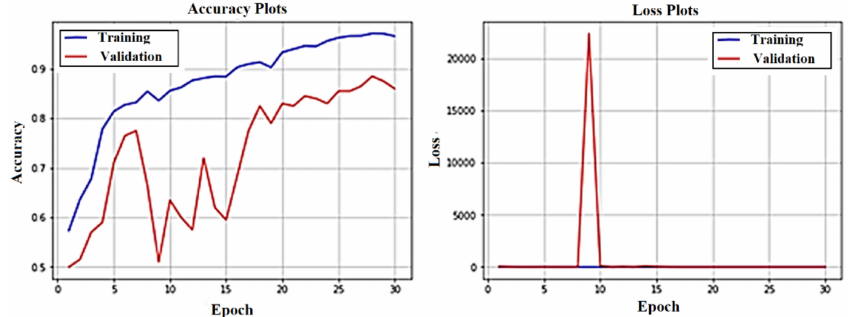
Figure 8. Accuracy and loss plots of MobileNet.